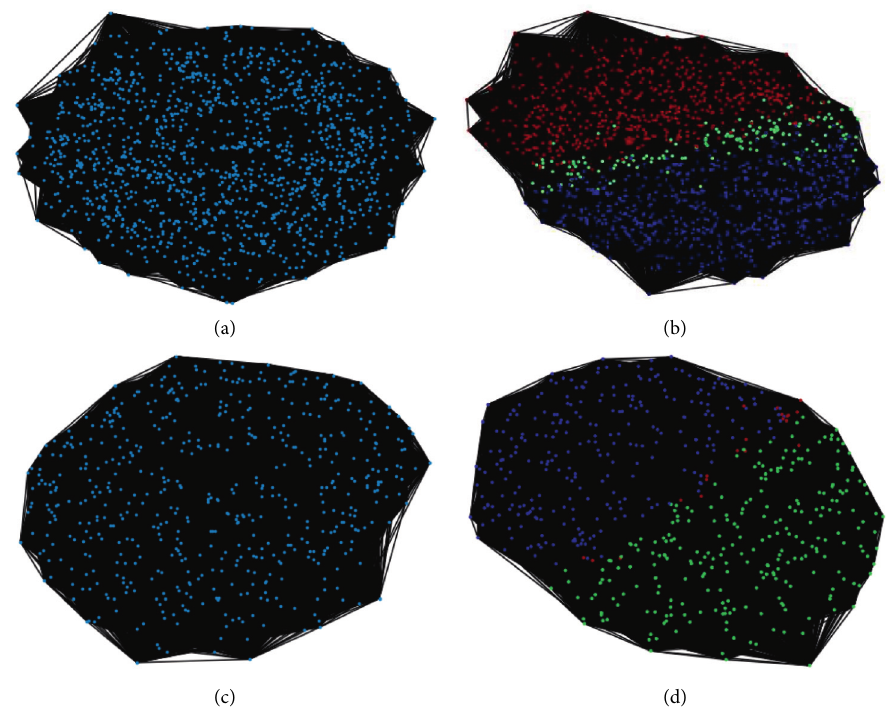
Figure 2: Analysis based on citation networks dataset using (a) original network using cit-HepPh dataset; (b) community detection using cit-HepPh dataset; (c) original network using the cit-HepTh dataset; (d) community detection using the cit-HepTh